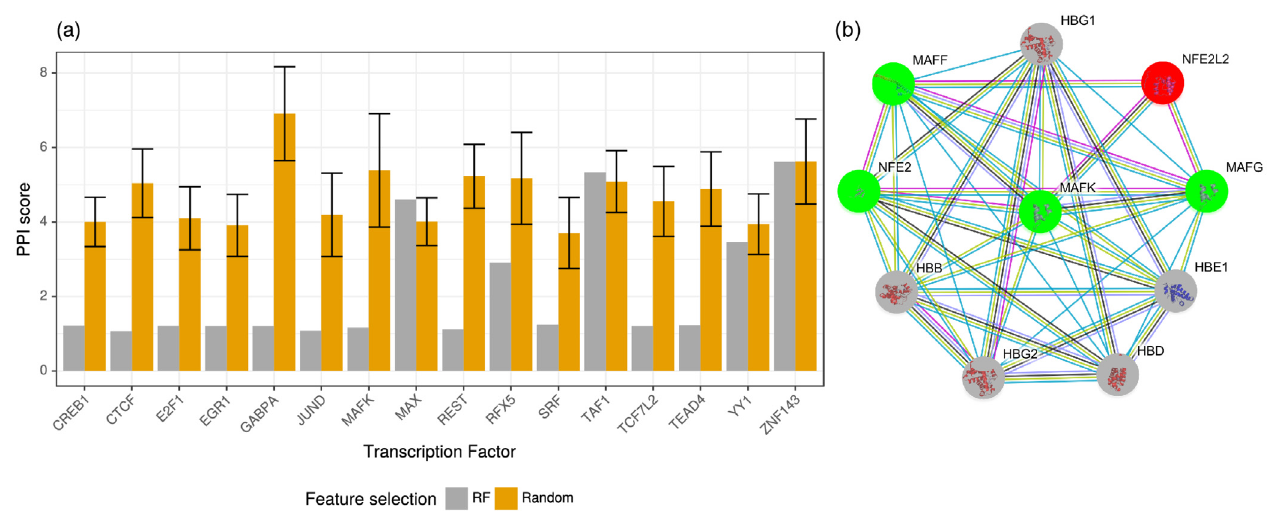
Figure 5. a ) Log transformed PPI scores computed for a set of TFs. In the Random case, we show the mean PPI score across 100 random draws and its standard deviation. The smaller the PPI score the better. Only for three TFs ( MAX, TAF1, ZNF143 ), the randomly sampled PPI score is better than or equal to the score derived for the TFs selected by the RF classifiers. b ) PPI network obtained from STRING centered around the TF MAFK , highlighting proteins that interact with MAFK with high confidence. Proteins colored in green were identified as important features in the RF classifiers, proteins shown in grey could not be retrieved by our model, because they are DNA-binding proteins, or we do not have a PWM for them in our set. Regulators shown in red could have been detected by the RF, but were not included in the top set of